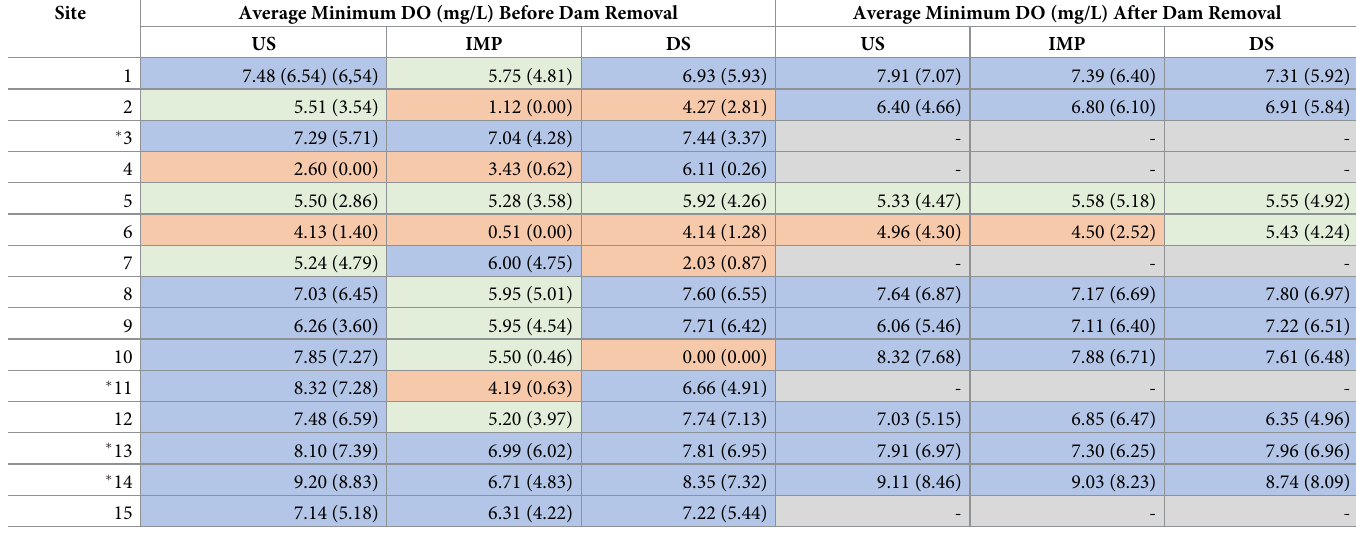
Table 4. Average daily minimum dissolved oxygen (DO) concentration in upstream (US), impoundment (IMP), and downstream (DS) reaches before and after dam removal. Overall minimum (i.e., lowest concentration recorded) in parentheses. Blue shading represents average minimum DO concentrations > 6 mg/L, green shading represents < 6 and > 5 mg/L, and orange shading represents < 5 mg/L, a threshold below which waters are considered impaired for DO (MDEP 2016). Grey shad- ing and dash symbols (-) indicate no dam removal occurred over the course of this study.